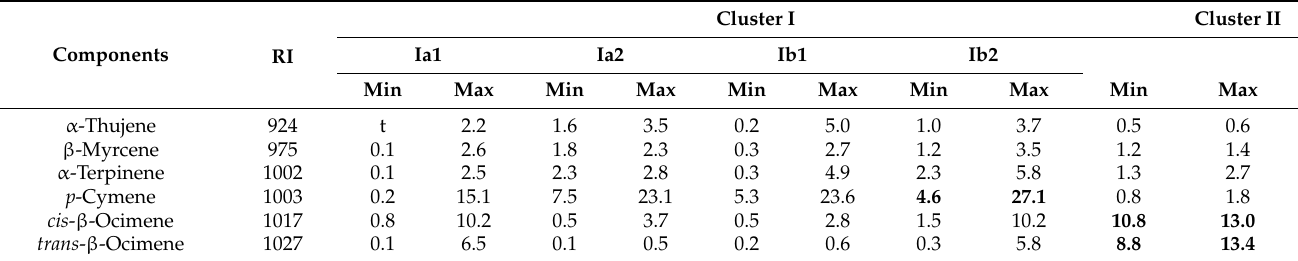
Table 2. Minimum and maximum percentage range of EOs’ main components ( ≥ 3% in at least one sample) isolated from the different Origanum vulgare subsp. virens accessions grouped according to cluster analysis. For samples grouped in each of the clusters and subclusters, see Figure 2. Full detailed composition is provided in SM Table